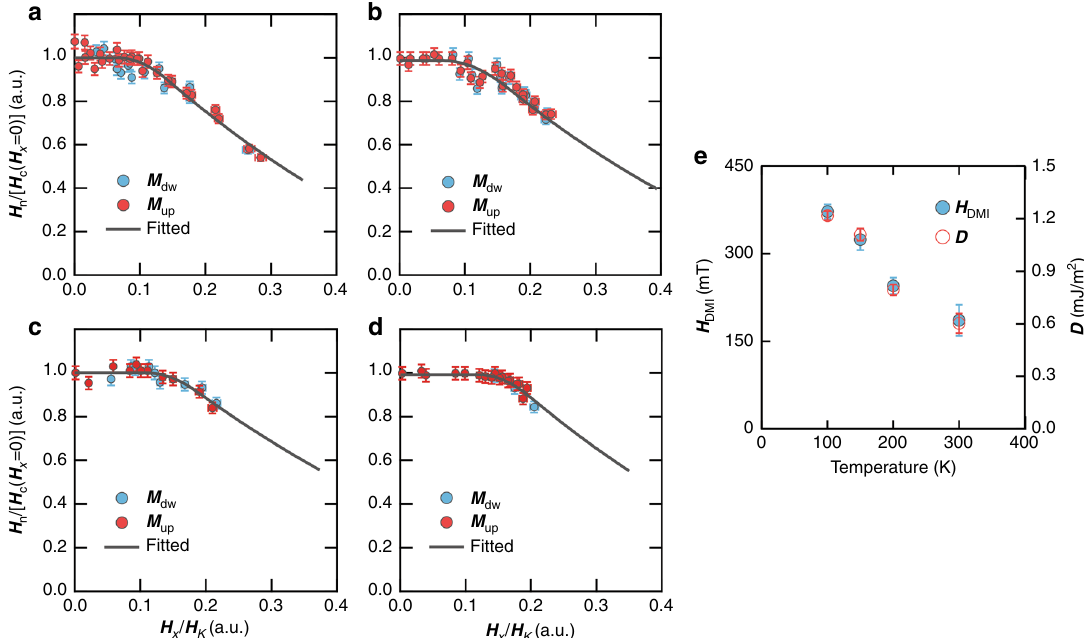
Fig. 2 H DMI measurement from the H n of the droplet. a – d The H n / H sw ( H x = 0) vs H x / H K plots measured at 300, 200, 150 and 100 K, respectively. The grey solid lines are the best fi tting results using the droplet model. Here the vertical axis is normalized by the nucleation fi eld H sw ( H x = 0) at H x = 0 and the horizontal axis is normalized by the effective perpendicular anisotropy fi eld H K . e Plots of H DMI and D in terms of T . The error bars are based on the standard deviation of the H DMI distribution from the best fi